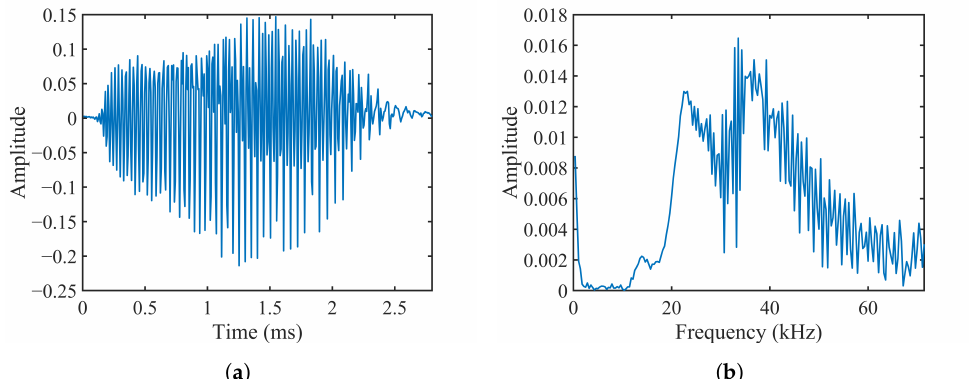
Figure 10. The base information of the bat signal. ( a ) Waveform. ( b ) Spectrum.